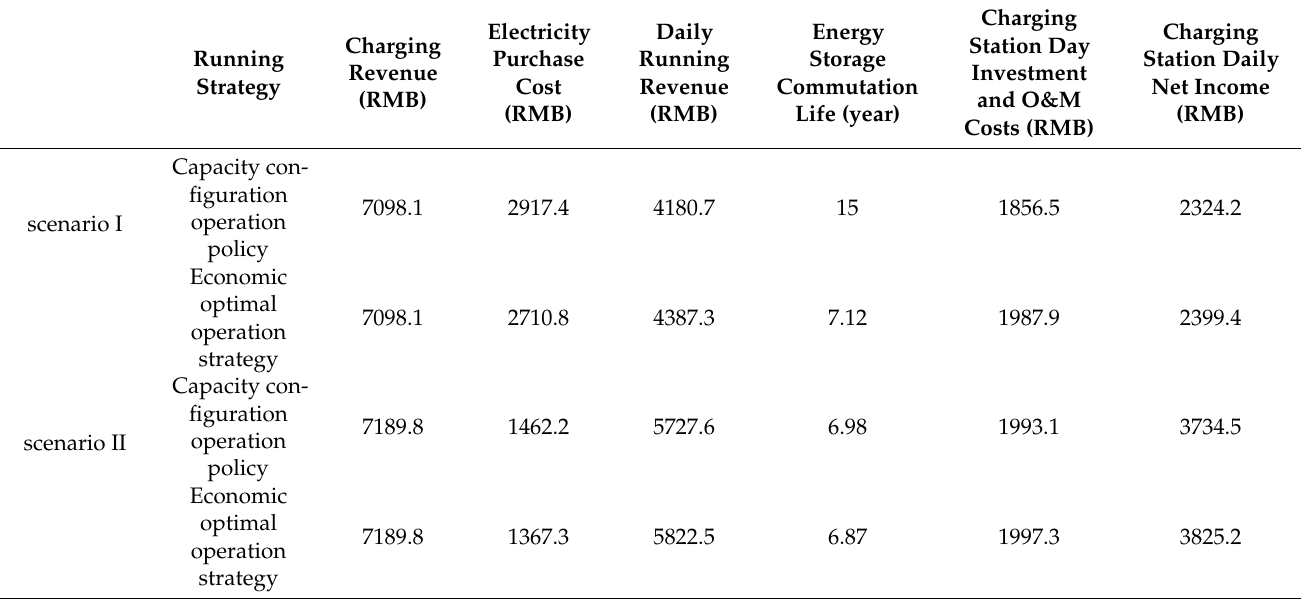
Table 2. Comparison result analysis under two operation